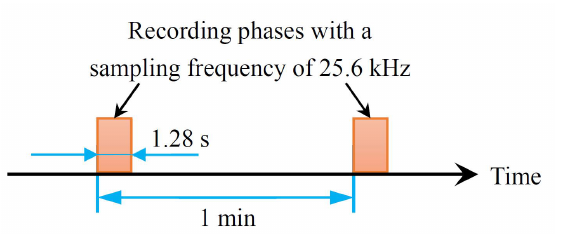
Figure 4. Bearing testbed.